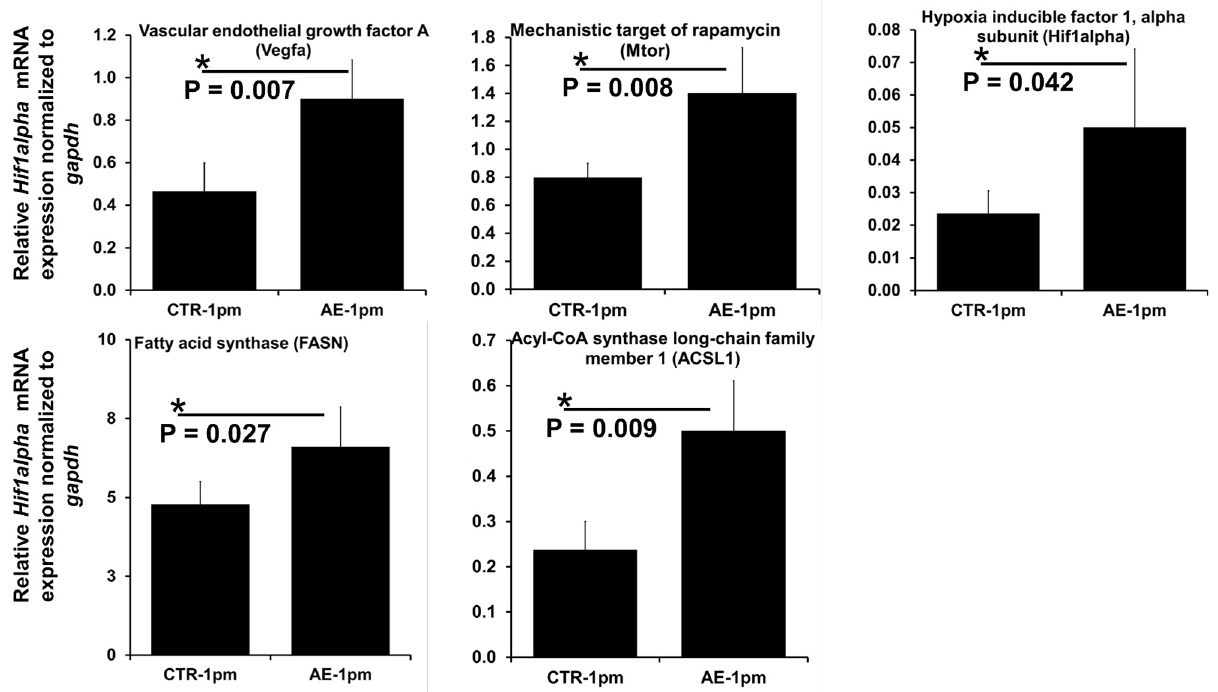
Fig 8. Relative mRNA level of angiogenesis- and lipid metabolism-related genes. Normalization was done using gapdh as endogenous reference. Bars represent median ± standard deviation. All qPCRs were carried-out using biological replicates (n = 5 mice from the infected group and n = 4 mice from uninfected group), with three technical replicates per